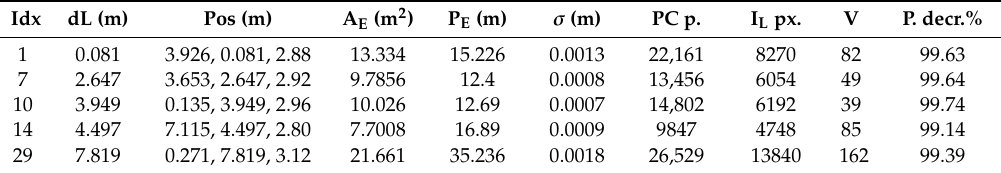
Table 3. Detected planes with the physical description in the Y-axis.